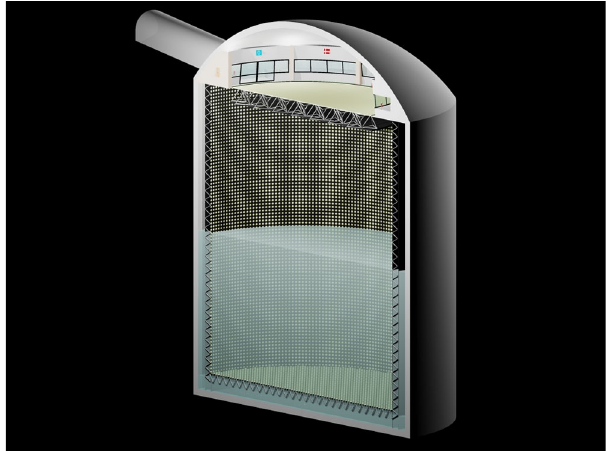
FIG. 21. The proposed MEMPHYS detector for the Super Beam and the Beta